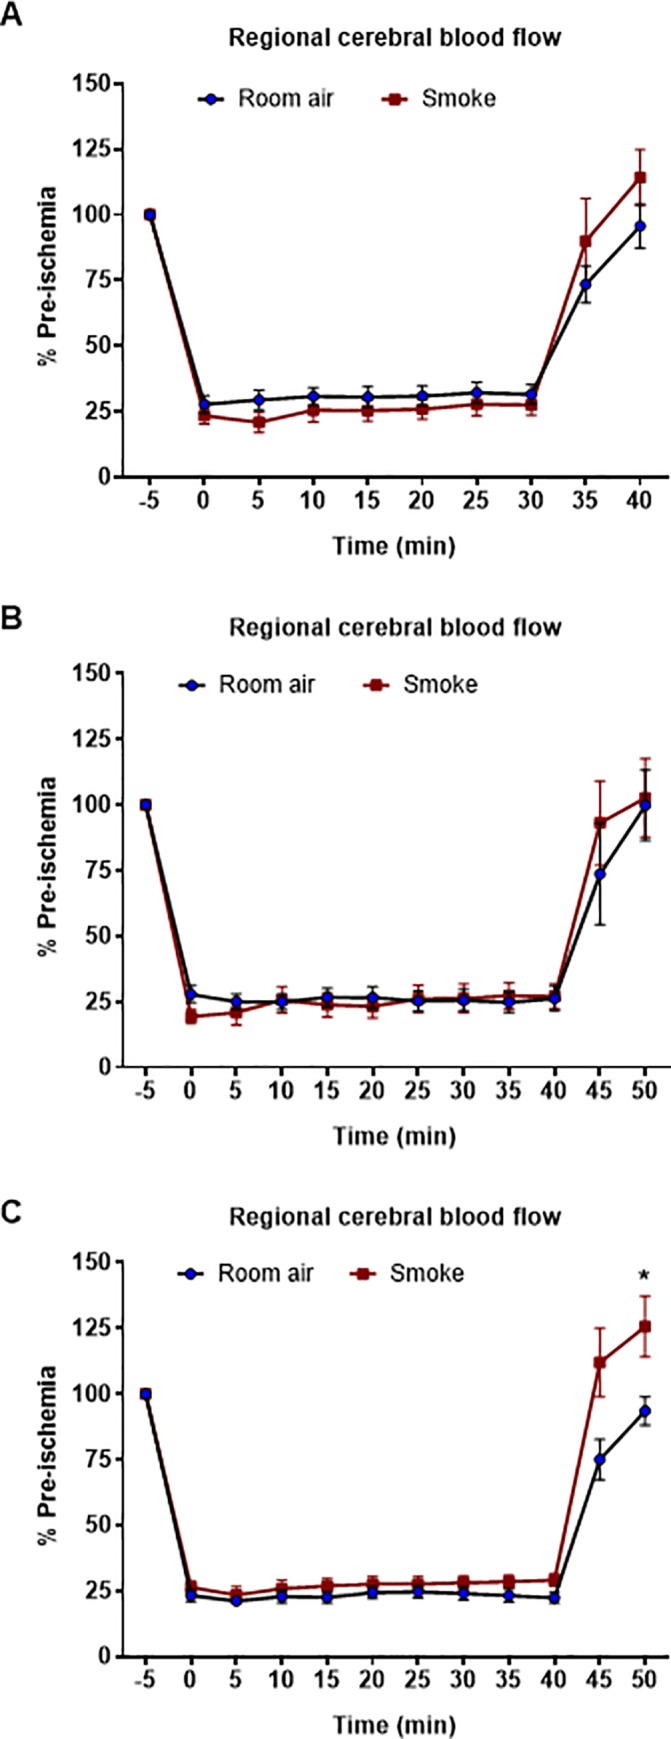
Regional cerebral blood flow during tMCAO surgery and during reperfusion.Surgeries were performed after 2 weeks (A; n = 8–10), 8 weeks, (B; n = 5–7) and 12 weeks (C; n = 8–10). Student’s unpaired t-test performed on final values, *P<0.05 vs room air group.